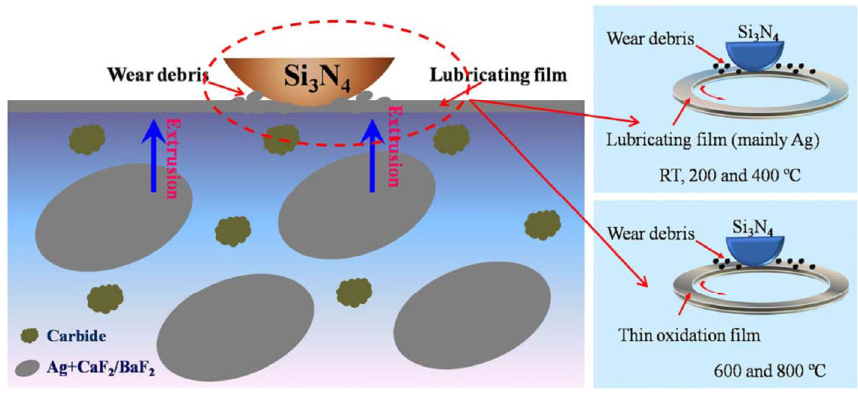
Fig. 13 Wear mechanism for composite at different